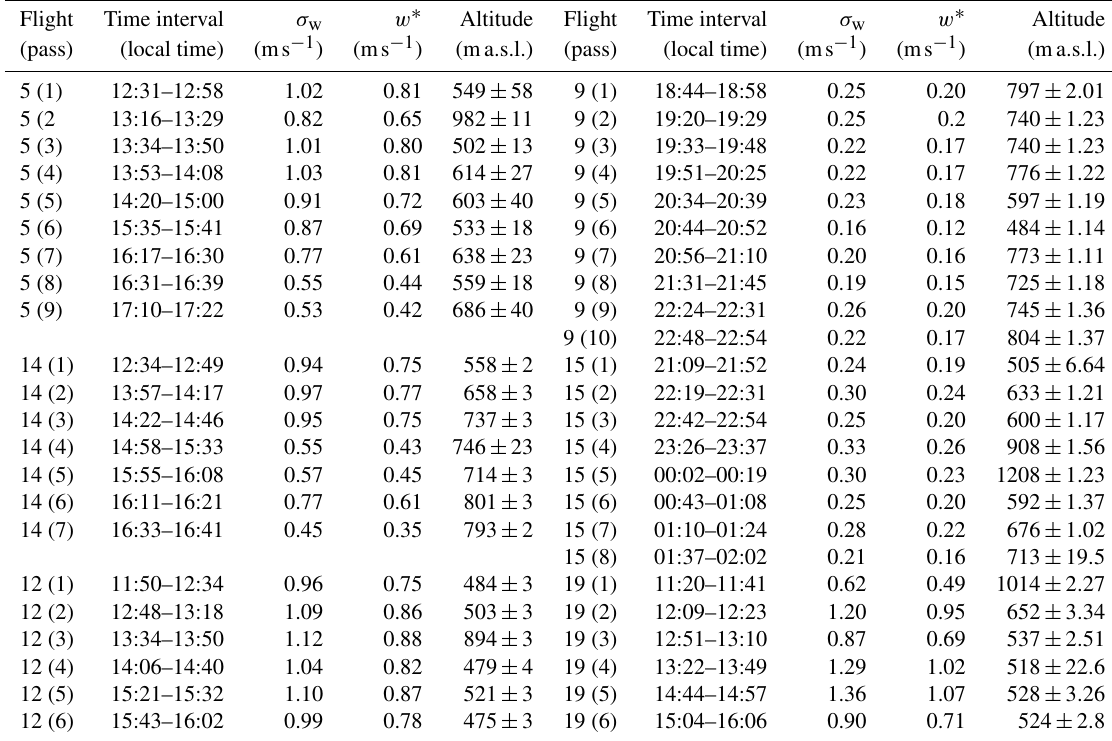
Table 2. Flight number, time interval, standard deviation of vertical wind velocity ( σ w ), and characteristic vertical velocity w ∗ = 0 . 79 σ w during flight segments where the aircraft flew at a constant altitude.